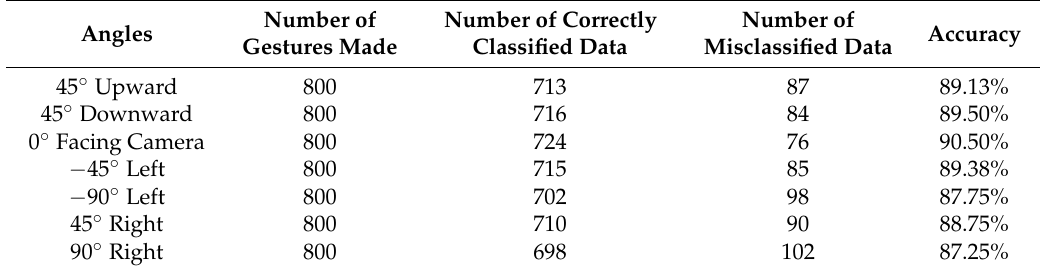
Table 5. Accuracy of musical conducting gesture recognition at different viewing angles.